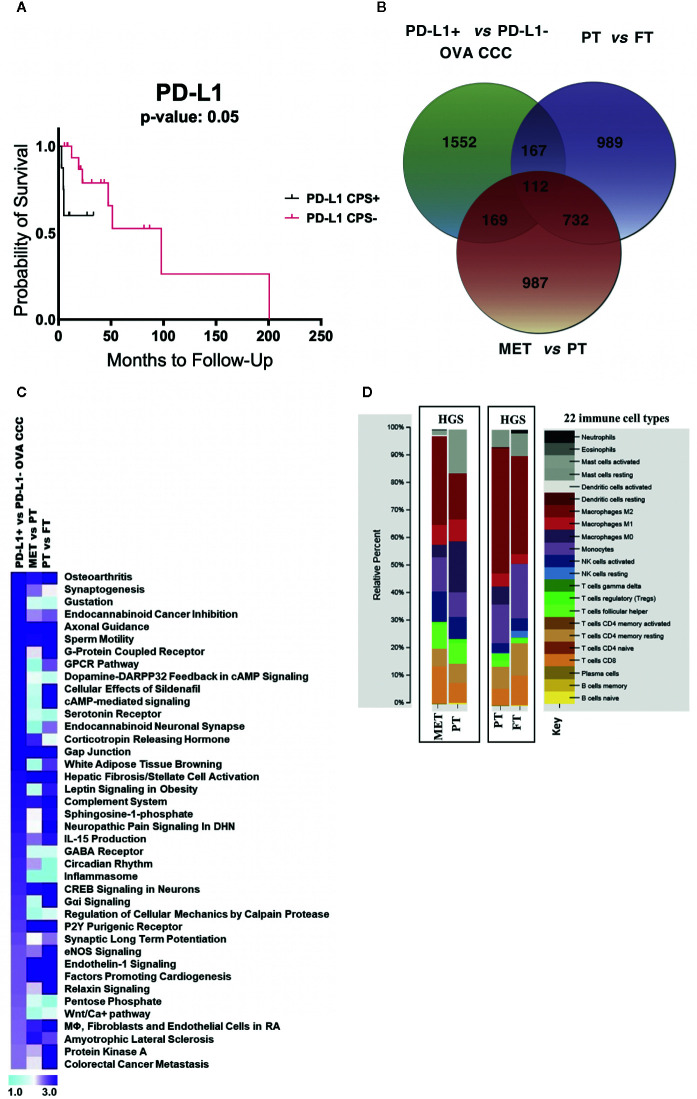
RNA-seq metadata analysis of ovarian cancer. (A) Kaplan–Meier curve displaying the effects of PD-L1 expression on ovarian cancer overall survival (11 PD-L1+ and 21 PD-L1−). (B) Venn diagram depicting the number of unique and overlapping differentially transcribed genes among top 2,000 genes across three different comparisons: (i) PD-L1+ (n = 6) vs PD-L1− (n = 5) CCC ovarian cancers; (ii) seven pairs of primary high grade serous ovarian cancers (HGSOC) and normal fallopian tubes; (iii) ten pairs of metastatic and primary HGSOC. (C) Comparative pathway analysis across the three datasets, sorted based on significantly enriched pathways (−log10 p-value > 1.9) in ovarian CCC compared to HGSOC patients. (D) CIBERSORT analysis of the relative proportions of 22 tumor infiltrating immune cell types (25) between HGSOC metastatic versus primary tumor, and between HGSOC primary tumors versus matched normal fallopian tubes (1,000 permutations). OVA CCC, ovarian clear cell carcinoma; HGSOC, high grade serous ovarian cancer; MET, metastatic tumor, high grade serous ovarian cancer; PT, primary tumor, high grade serous ovarian cancer; FT, normal fallopian tube.